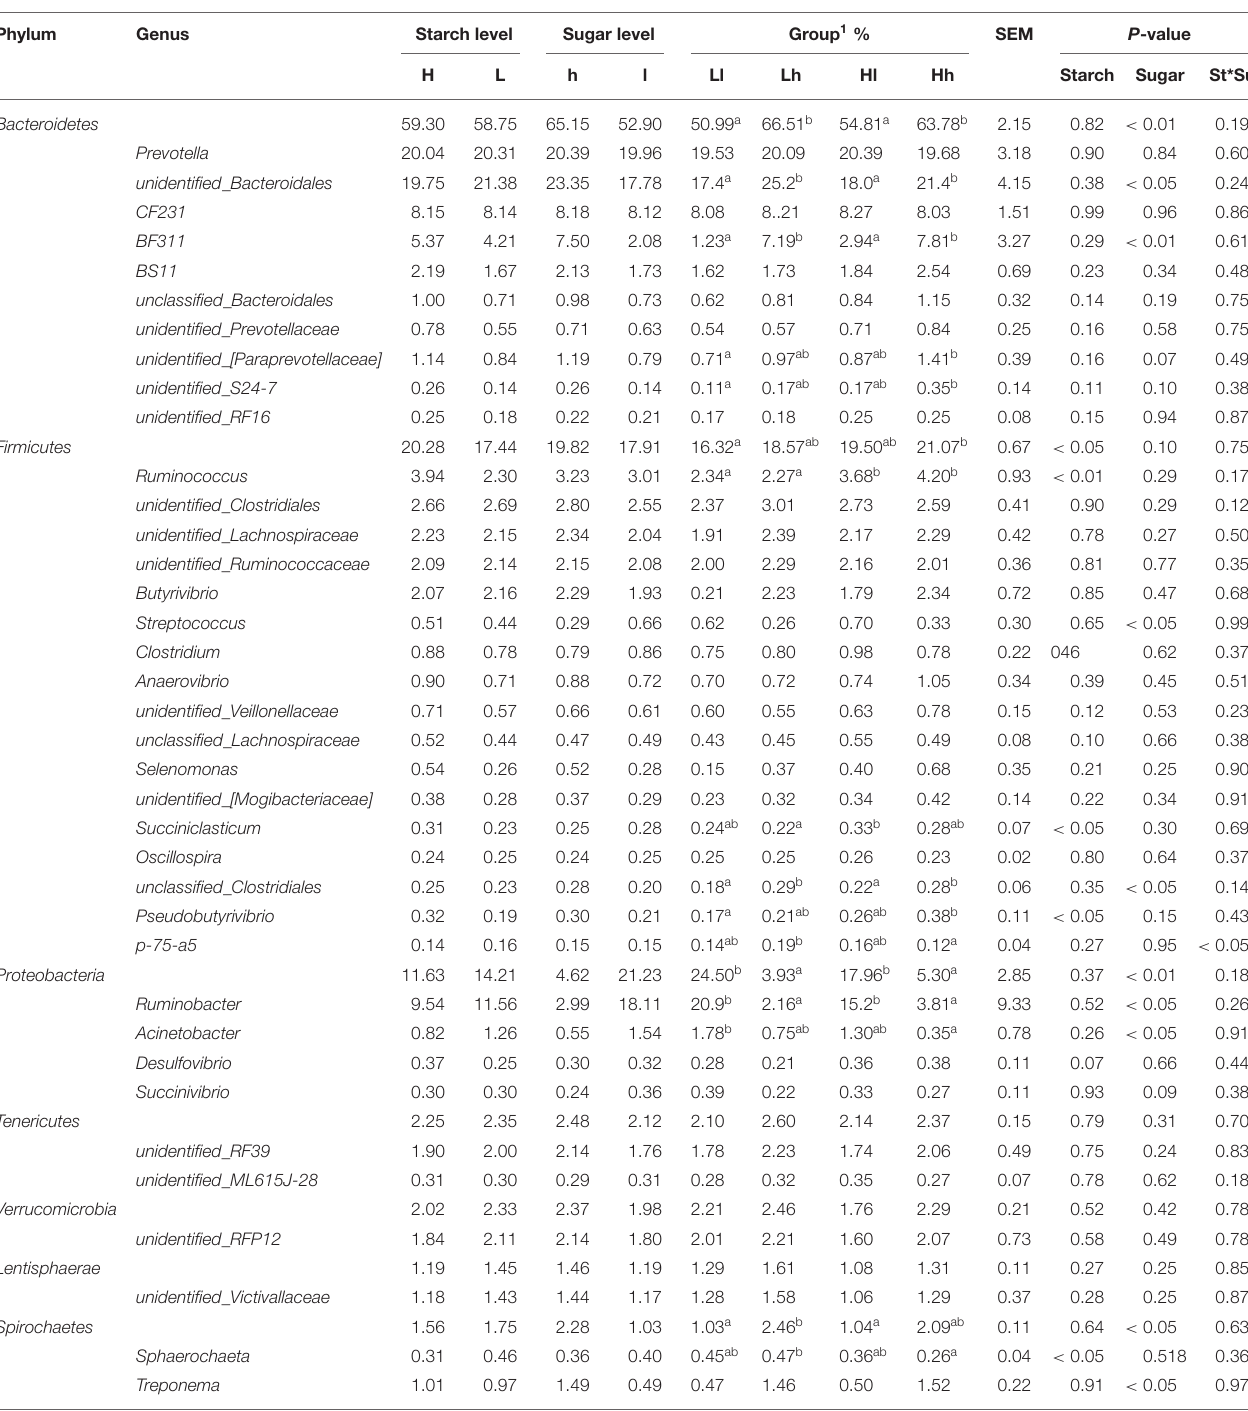
TABLE 5 | Comparison of rumen bacterial genera in each group (%).